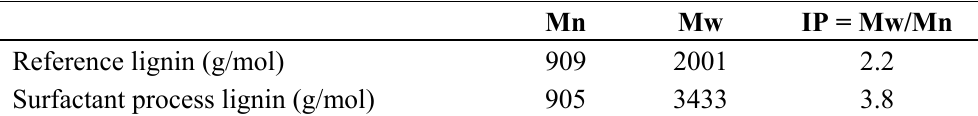
Table 3. Molecular weight of lignin